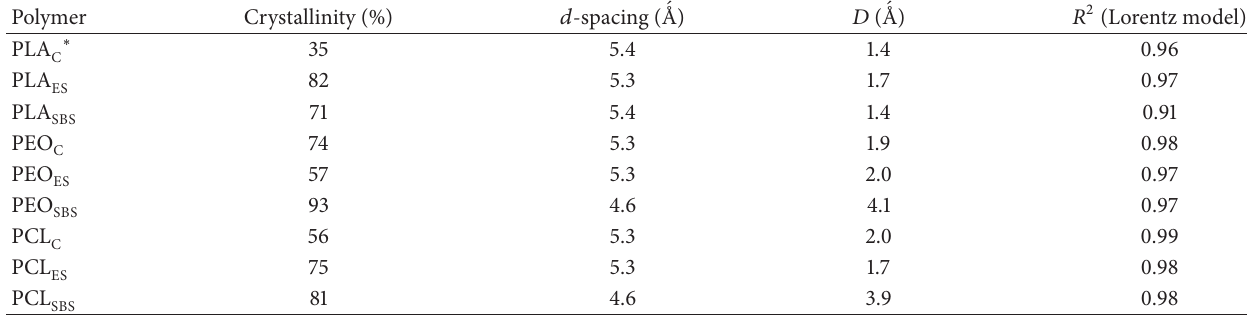
Table 5: Crystalline structure parameters for PLA, PEO, and PCL.